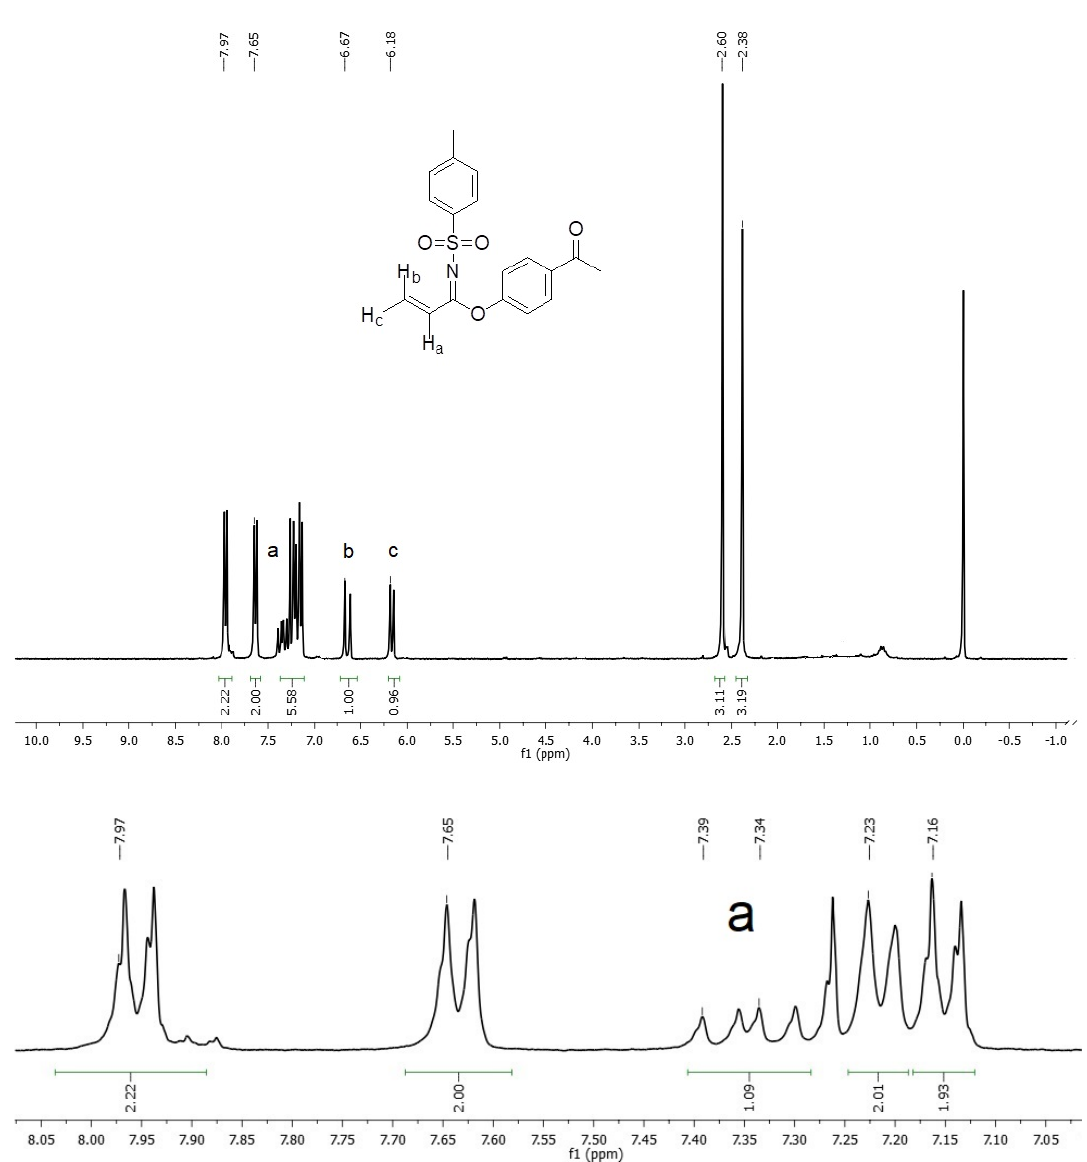
Figure 1. 1 H NMR spectrum of imidate 3